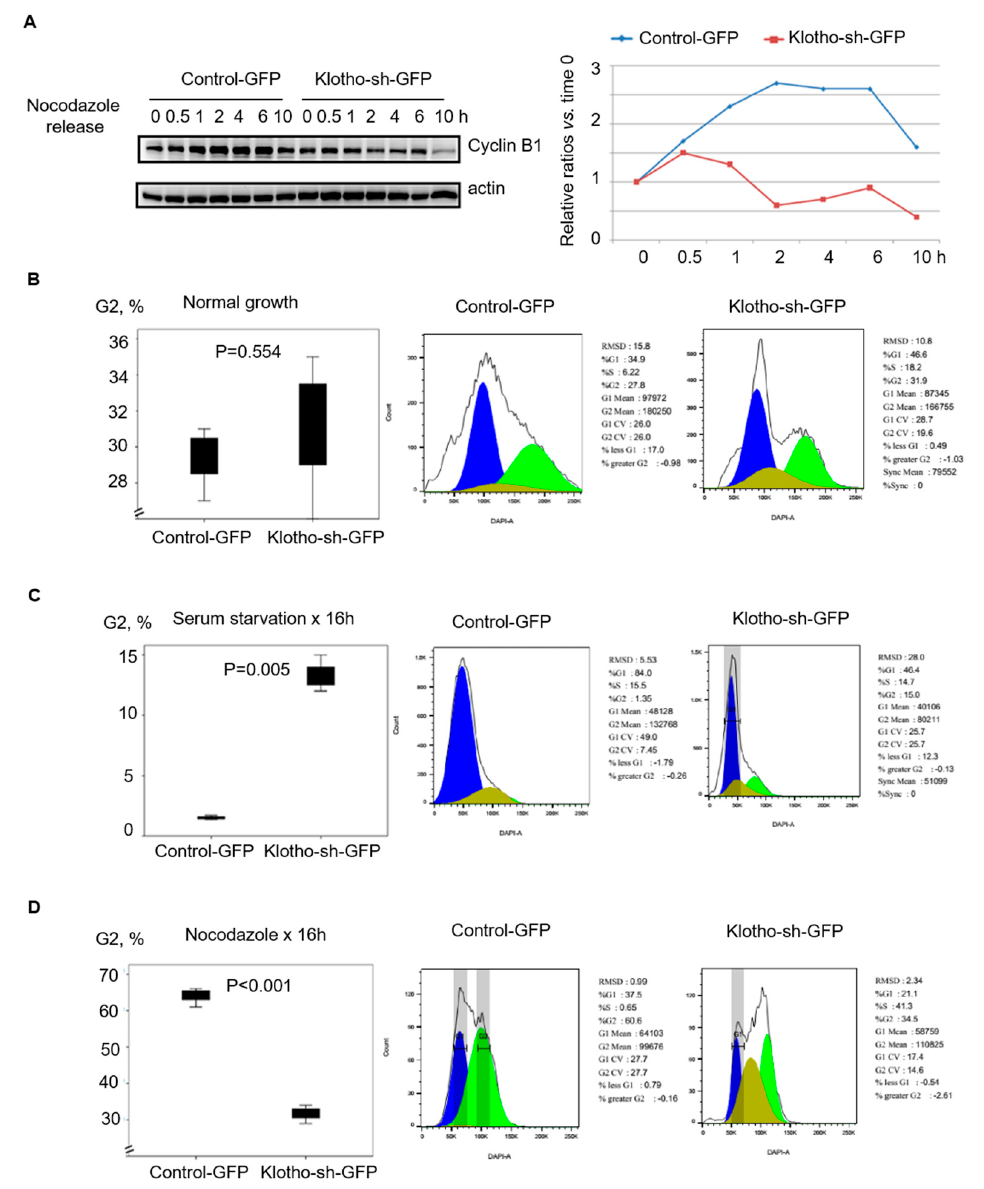
Figure 2. Klotho depletion causes aberrant cell cycle in HEK293 cells. HEK293 cells transfected with control-green fluorescent protein (GFP) or Klotho-sh-GFP for 24 h selected by flow cytometry were cultured with indicated condition, as indicated by the figure legends. ( A ) The protein expression of cyclin B1 was evaluated by Western blotting after treatment with nocodazole. ( B – D ) Cell cycle analysis after treatment with varying conditions, as indicated in the figure legends, was done with Propidium iodide staining followed by flow cytometry analysis. Each reaction was repeated in triplicate. Representative histograms of cell cycle distribution in all treatments are demonstrated (means ± standard error of the mean (SEM); one-way analysis of variance (ANOVA)).